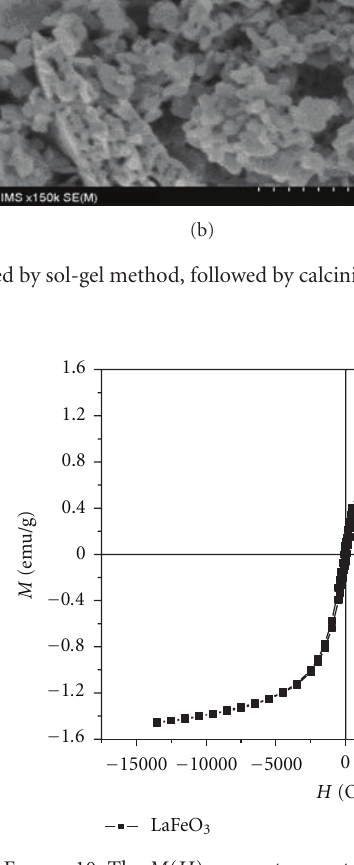
Figure 10: The M ( H ) curve at room temperature of nano-LaFeO 3 prepared by sol-gel